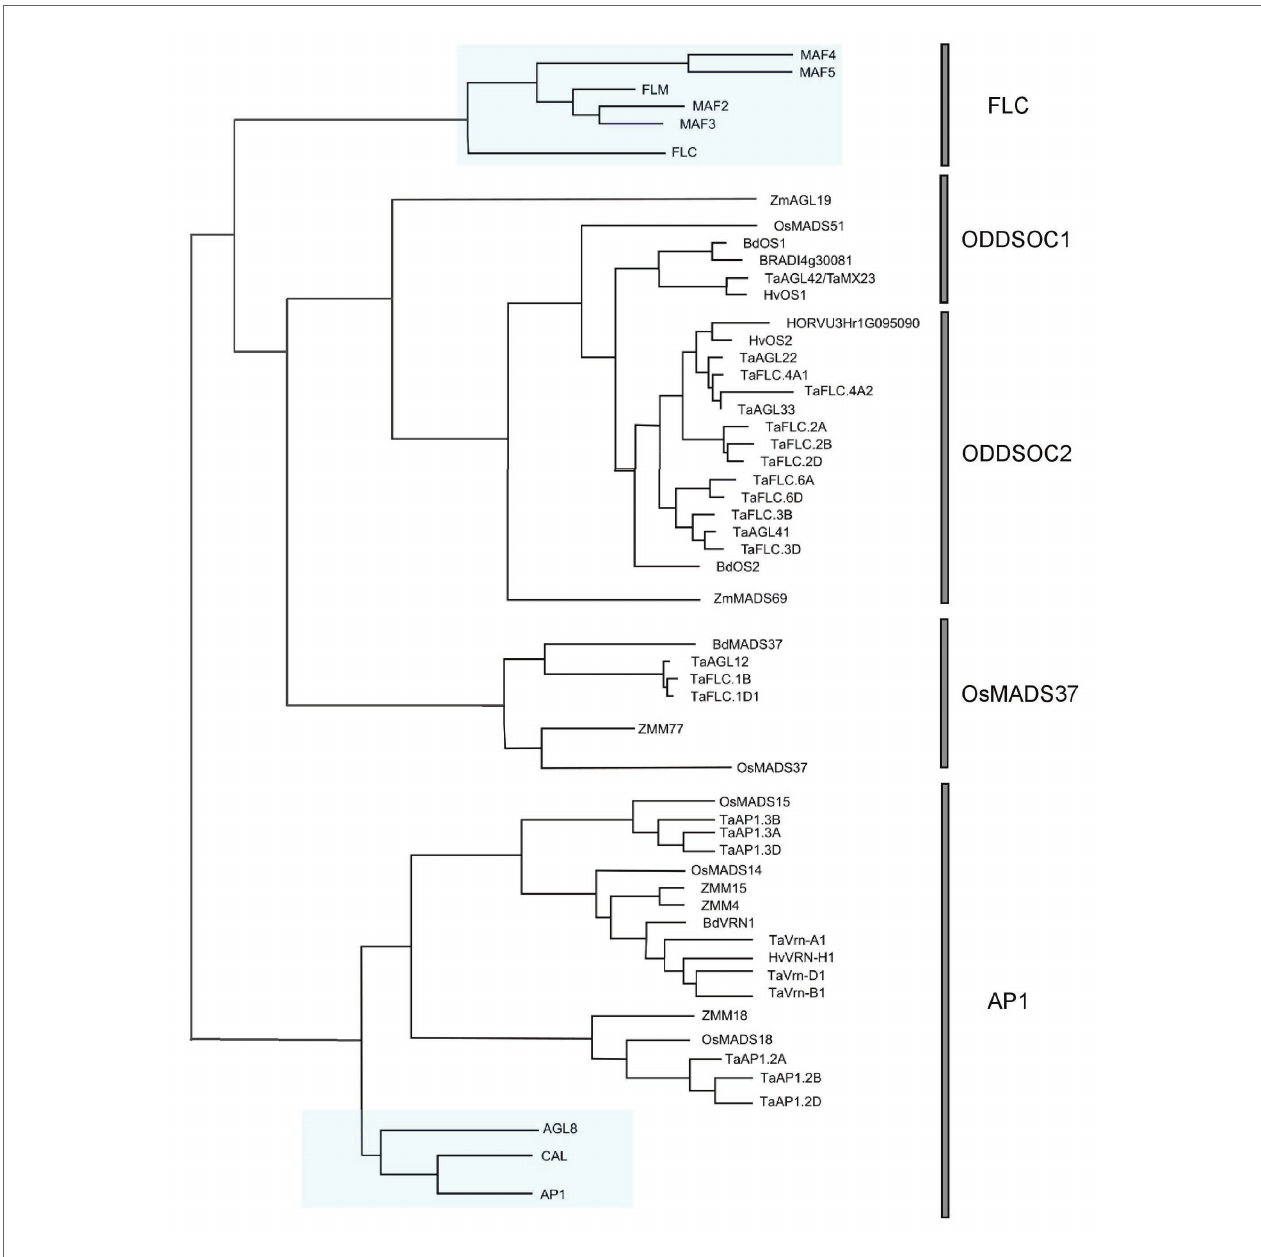
FIGURE 1 | Phylogenetic relationships of all FLOWERING LOCUS C ( FLC ) genes annotated in cereals. A maximum likelihood phylogeny was generated using Geneious Pro v5.5.4 using MADS-box genes from eudicots and monocots. A reconstructed phylogeny containing only FLC and AP1 genes was drawn using InkScape. AP1 genes were used as an outgroup. Arabidopsis genes are highlighted in blue. A full version of the tree including all accession numbers can be found in Supplementary Figure S1